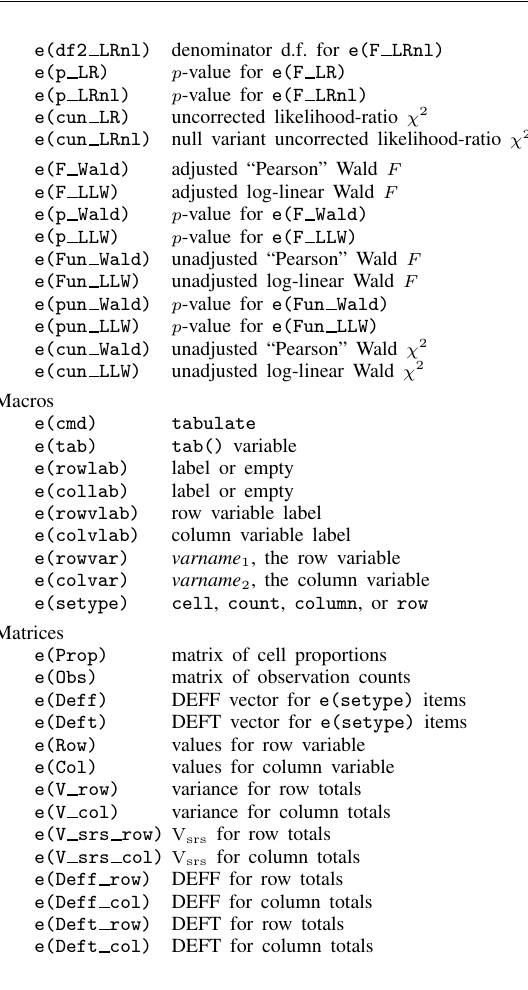
166 svy: tabulate twoway — Two-way tables for survey